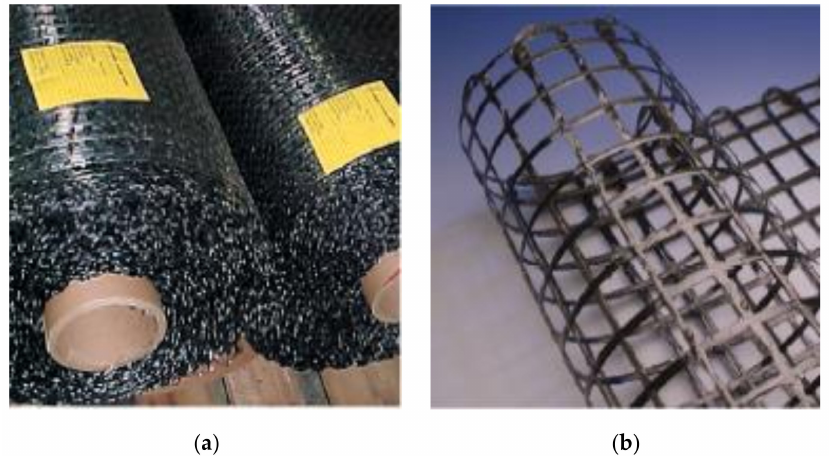
Figure 1. ( a ) CFRP grid rolls as received from the factory, and ( b ) CFRP grid formed into a tubular (coil) configuration (most effective configuration for concrete confinement) (photos courtesy of